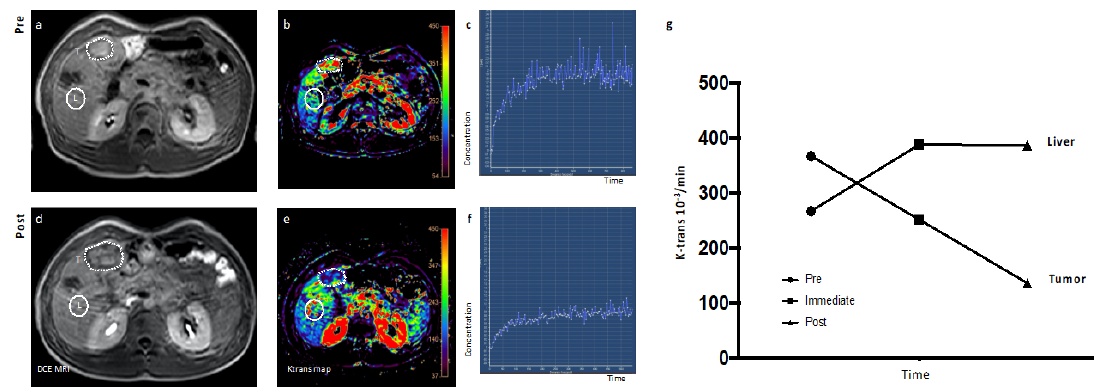
Figure 4. Early evaluation of activity of tTF-NGR using Dynamic Contrast-Enhanced Magnetic Resonance Imaging (DCE-MRI): Transverse images show the liver in a 22-year-old patient (UPN 003) with metastatic non-seminomatous germ cell tumor as treated in cycle 1 (1 mg/m 2 tTF-NGR per day). Images of tumor (T) before ( a – c ) and after five days of therapy ( d – f ): Comparisons of tumor diameter before treatment (dotted line ( a )) versus after treatment (dotted line ( d )) reveal a moderate increase in tumor diameter 5 days after the beginning of treatment. Comparisons of tumor perfusion maps (volume transfer coe ffi cient k-trans) demonstrate a notable reduction in tumor perfusion ( b , e ). Modelled perfusion parameter (k-trans) from before treatment ( c ) and after treatment ( f ) show a reduction in calculated k-trans values of > 50% and delayed enhancement kinetics, indicating a substantial reduction in tumor perfusion. In contrast, healthy liver tissue (L in Figure 4a) shows a moderately enhanced perfusion after therapy. The line diagram ( g ) visualizes a first reduction of tumor perfusion already 5 h after treatment initiation (immediate) compared to the baseline scan (pre), with further decrease after five days of therapy